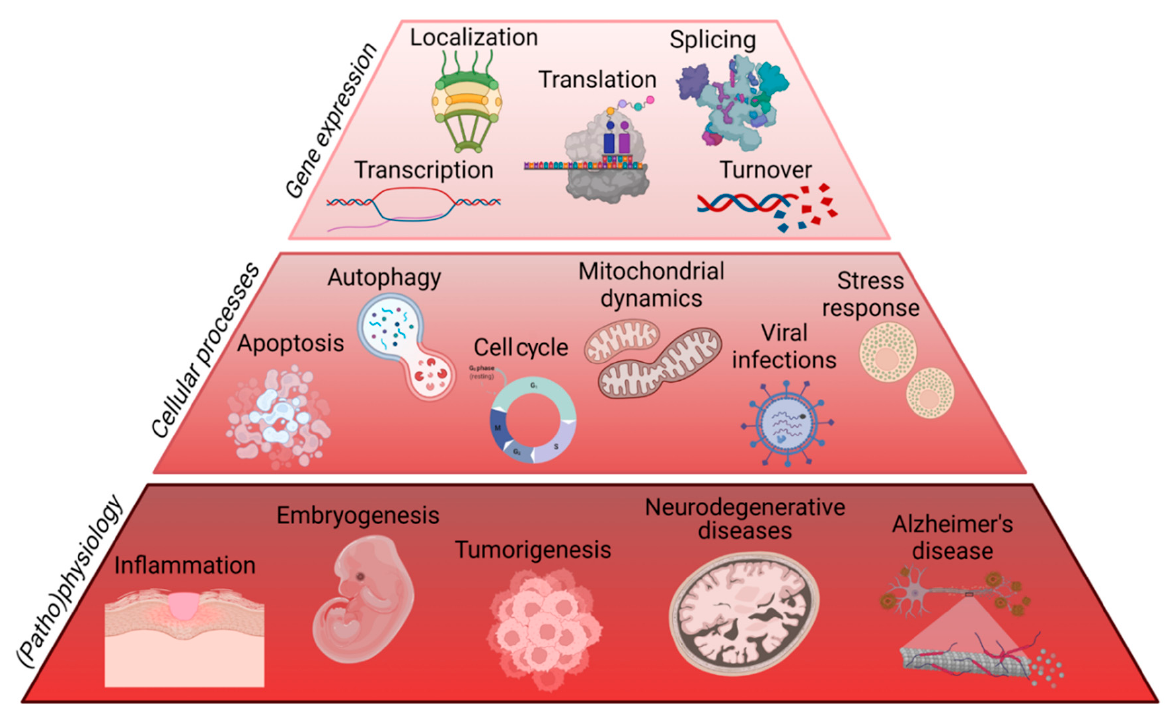
Figure 5. The multifunctional characteristics of TIAR on gene expression flux, cellular events and pathophysiological situations. Figure created with BioRender.com (accessed on 12 June 2022).